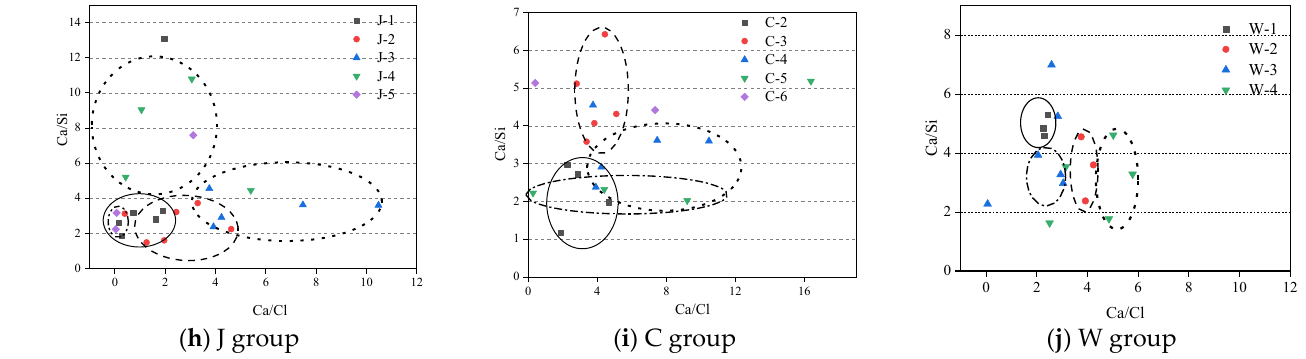
Figure 4. SEM images ( a – g ) and EDS results ( h – j ) of all 28 d net slurry specimens at different groups. The EDS results of marked points are shown in Figure 4. Among them, Ca/Si of raw material GGBS is 2.24 and Ca/Al is 4.148, and the mean Ca/Si and Ca/Al in J-4 Spot 4, J-5 Spot 1, C1 Spot 3, and Spot 6 areas are 2.36 and 4.42, respectively, which are fitted with those in the raw material GGBS, suggesting that the corresponding material belongs to